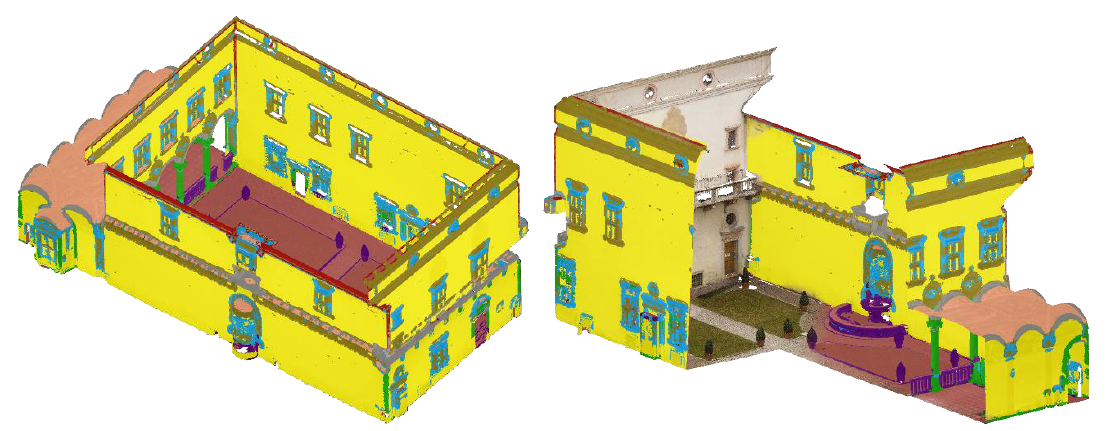
Figure 10. Classification results: generalisation level #3, dataset D.